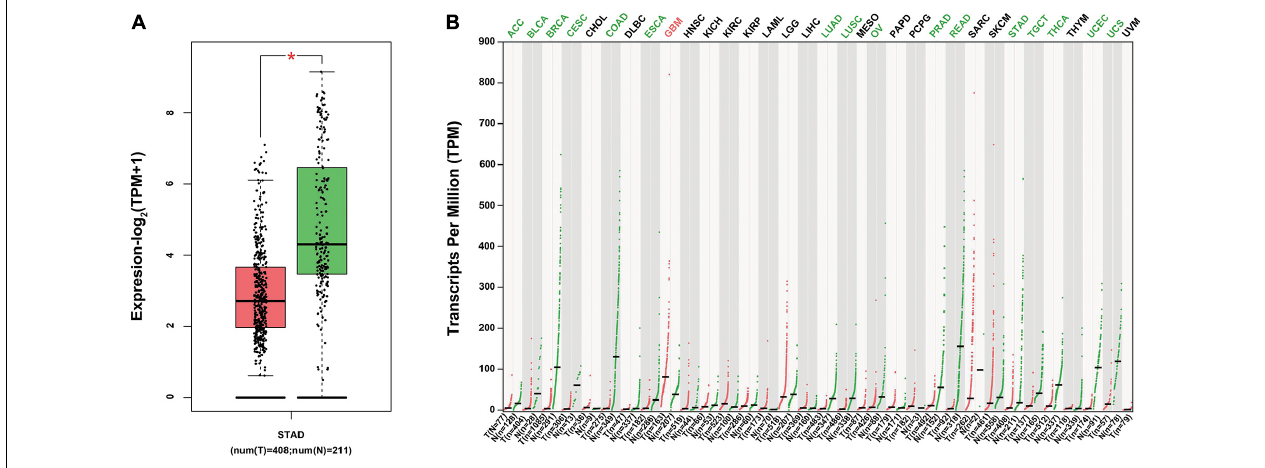
FIGURE 1 | The expression of ITGA7 in various cancer tissues using TCGA. (A) ITGA7 was lowly expressed in STAD * P < 0.05. (B) ITGA7 lowly expressed in many cancer tissues but highly expressed in